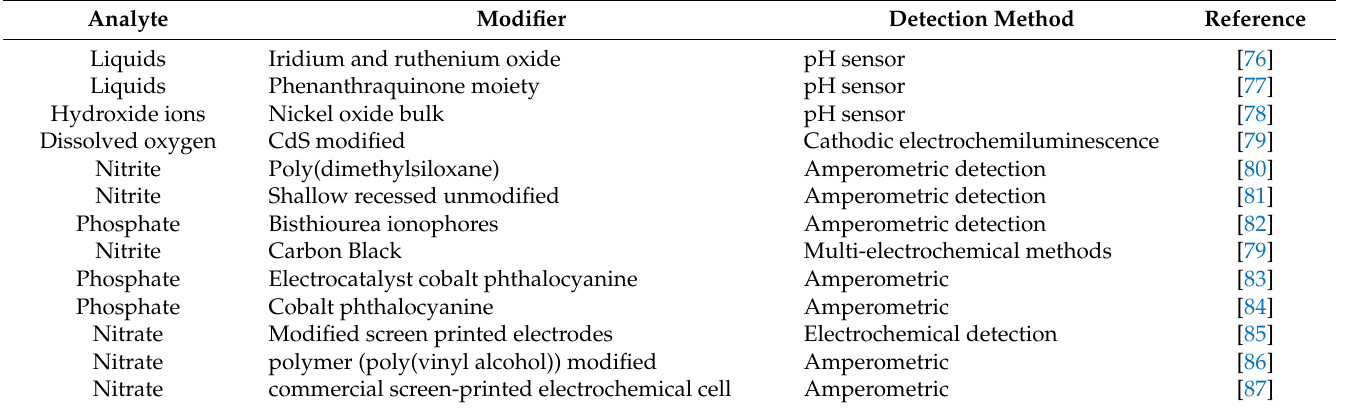
Table 3. Some of the recently developed screen-printed sensors for water quality tests.